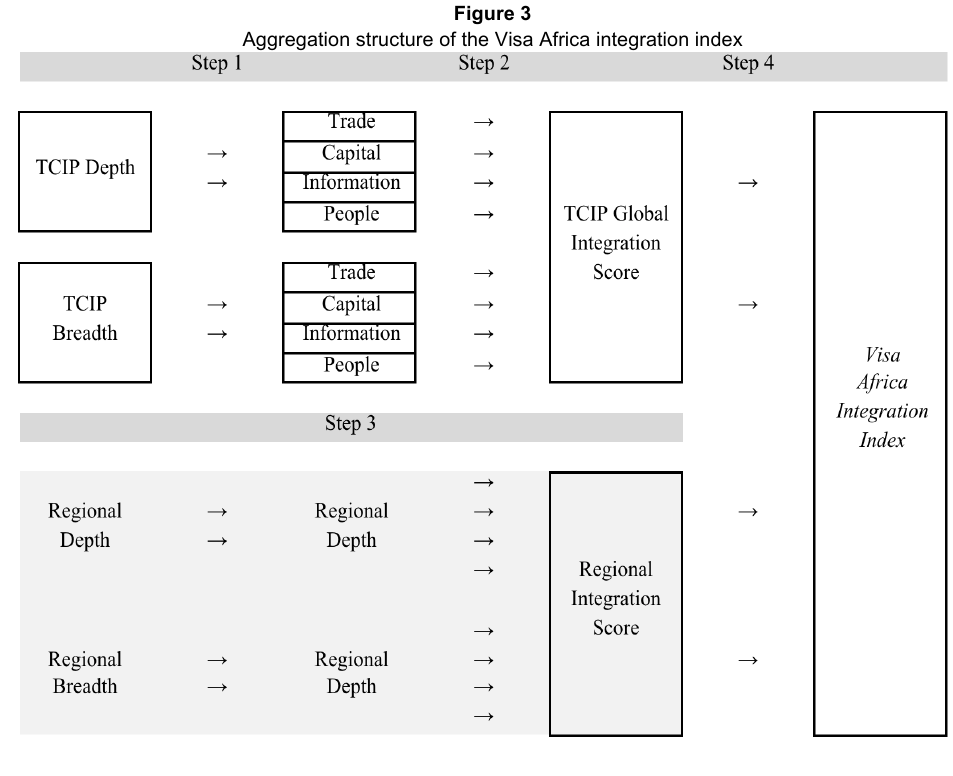
Figure 3 Aggregation structure of the Visa Africa integration